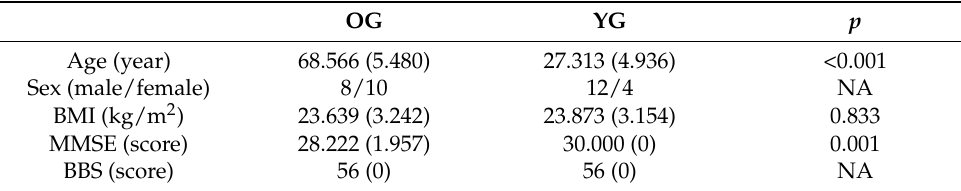
Table 1. The characteristics of all participants. The first values represent group means while the values in the brackets stand for their standard